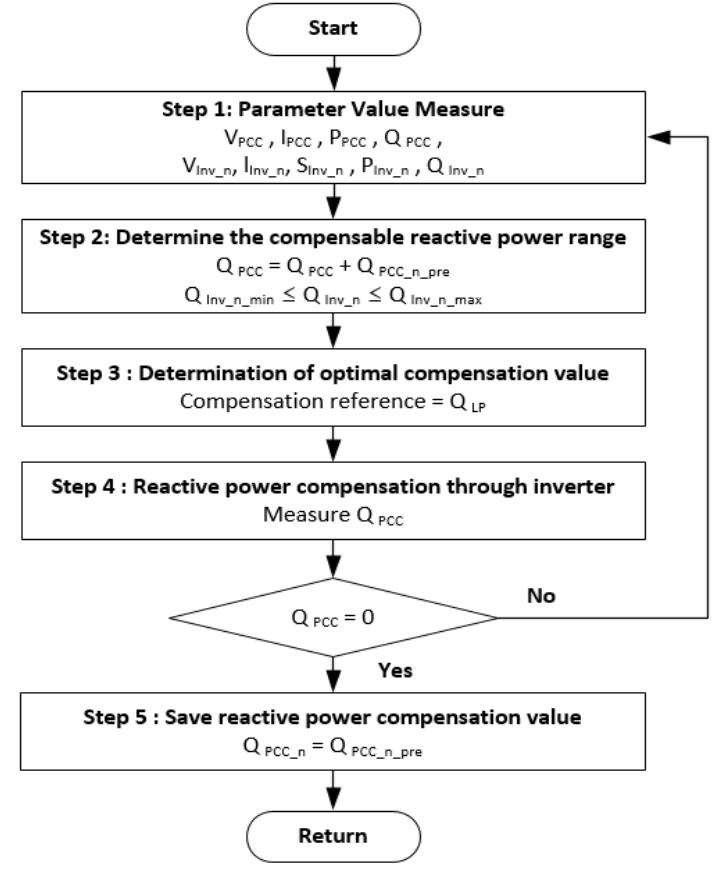
Figure 6. Virtual STATCOM Integrated Control Algorithm Diagram.